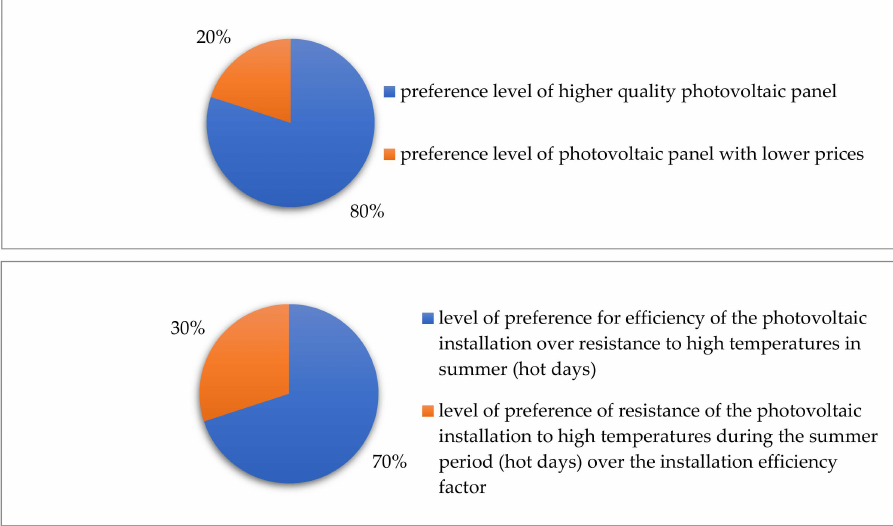
Figure 5. User preferences for the single-family house planned for construction in Turawa-Marszalki. Building technical data: type of roof—pitched equal. Table 11 provides the lengths of the building walls (the length of the front wall—10 m, the length of the right wall and 8